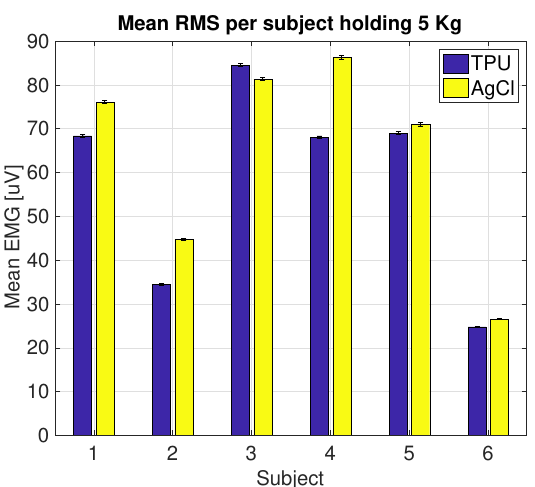
Figure 12. Normalized mean envelope value and standard deviation of all subjects performing the 5kg load test.